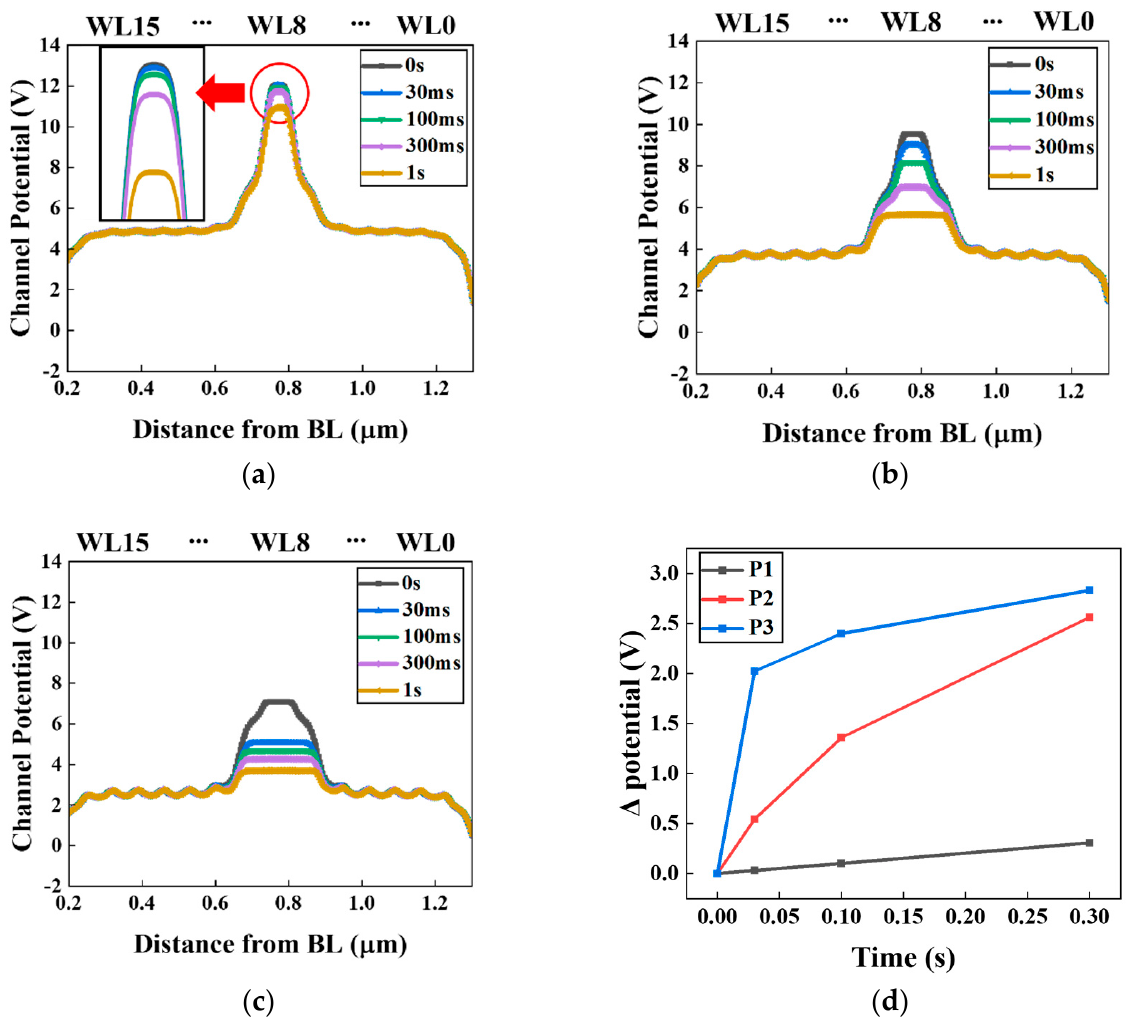
Figure 3. NLSB effect analysis according to transient time ( a ) V th = P1, ( b ) V th = P2, ( c ) V th = P3 and ( d ) is the Δ potential of selected WL at P1, P2, and P3.